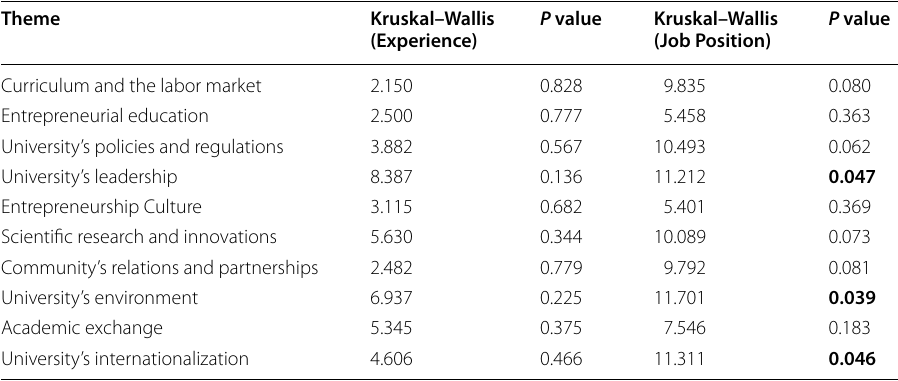
Table 5 Results of Kruskal–Wallis test of differences of the respondents’ perspectives towards an entrepreneurial university model according to the years of experience and the current job position